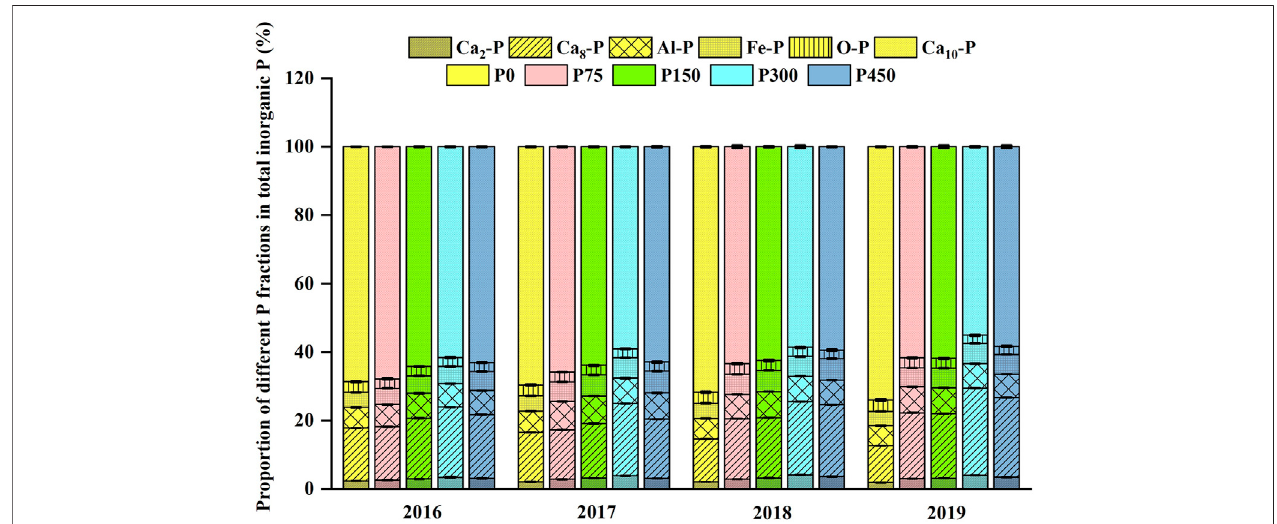
FIGURE 2 | Proportion of different P fractions in the total inorganic P in 2016 –